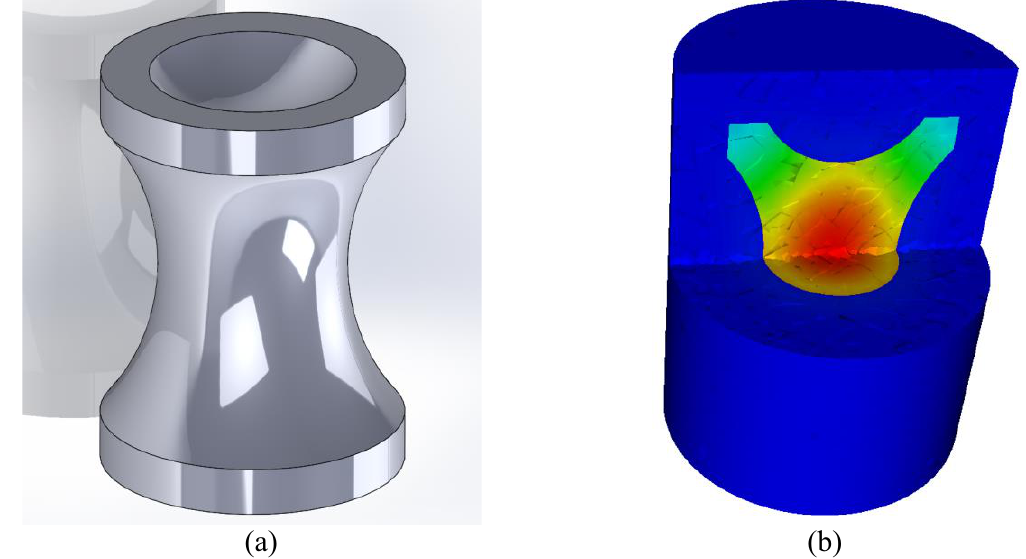
Figure 4. (a) Geometry of hourglass core (b) power distribution calculated by